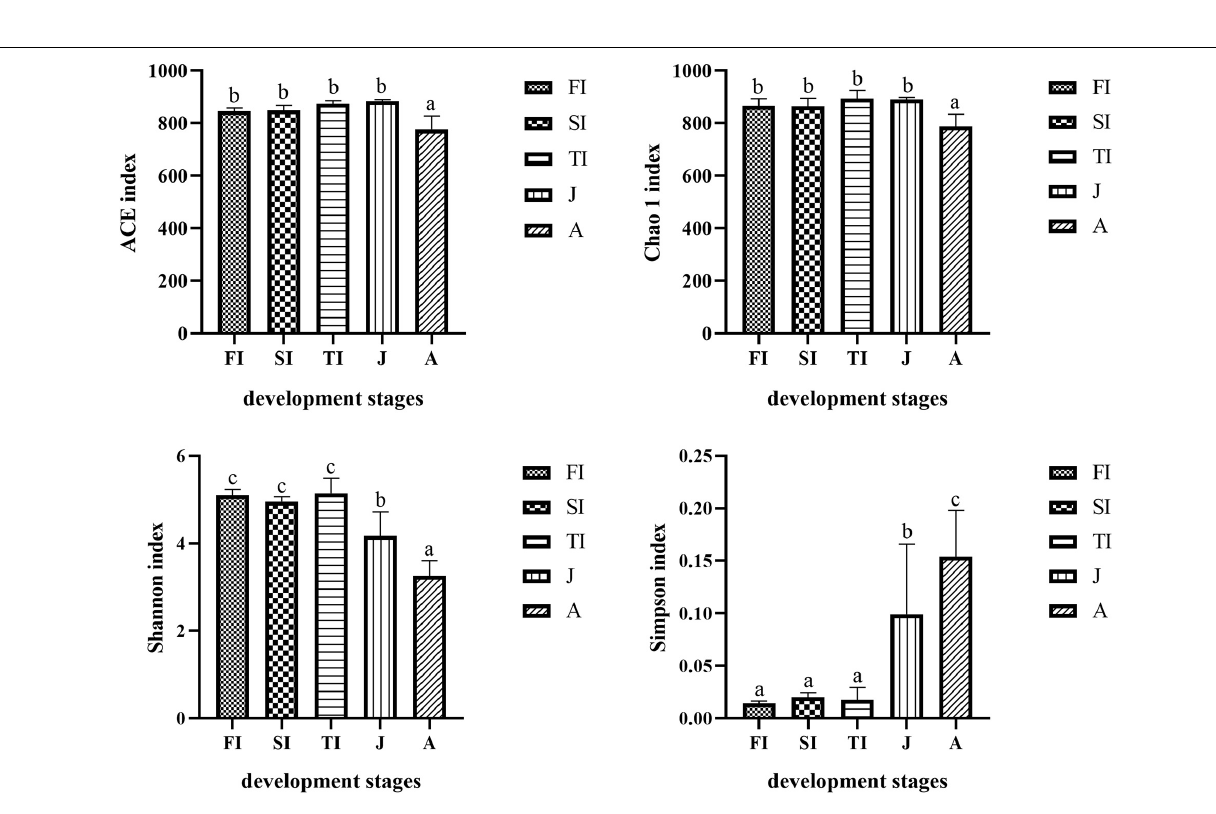
Frontiers in Microbiology |